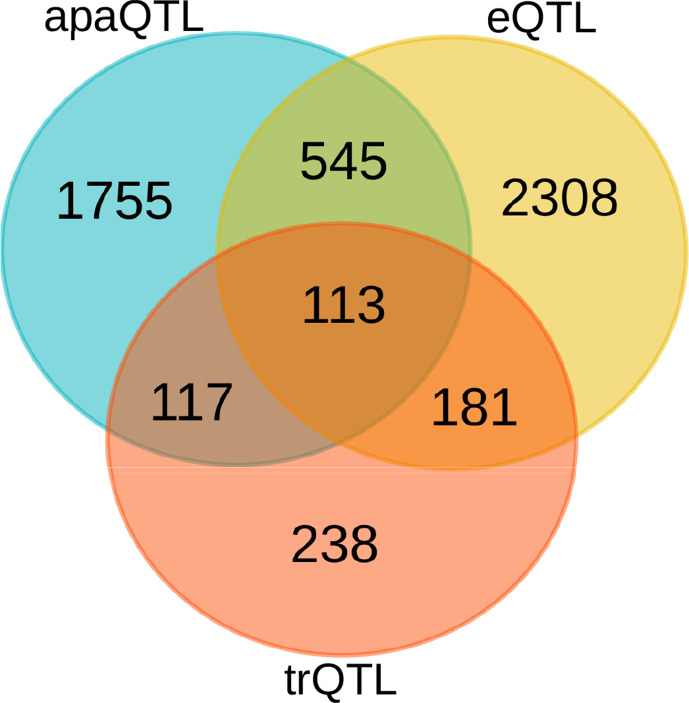
Comparison of genes with different molecular QTLs. Overlap between genes with significant alternative polyadenylation QTL (apaQTL), expression QTL (eQTL), and transcript ratio QTL (trQTL).